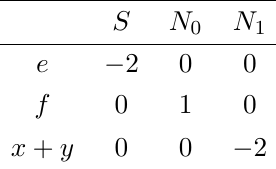
Table 6 . The full curve-divisor intersection matrix in the M-string